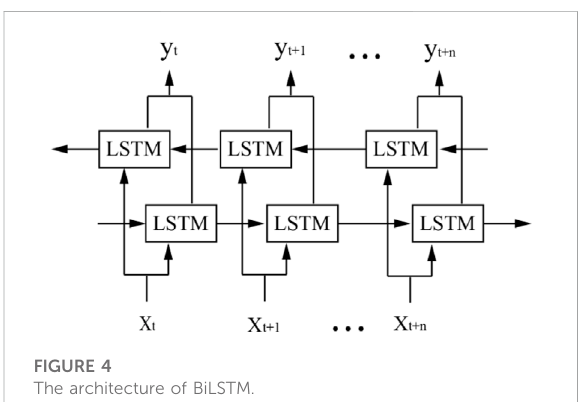
FIGURE 4 The architecture of